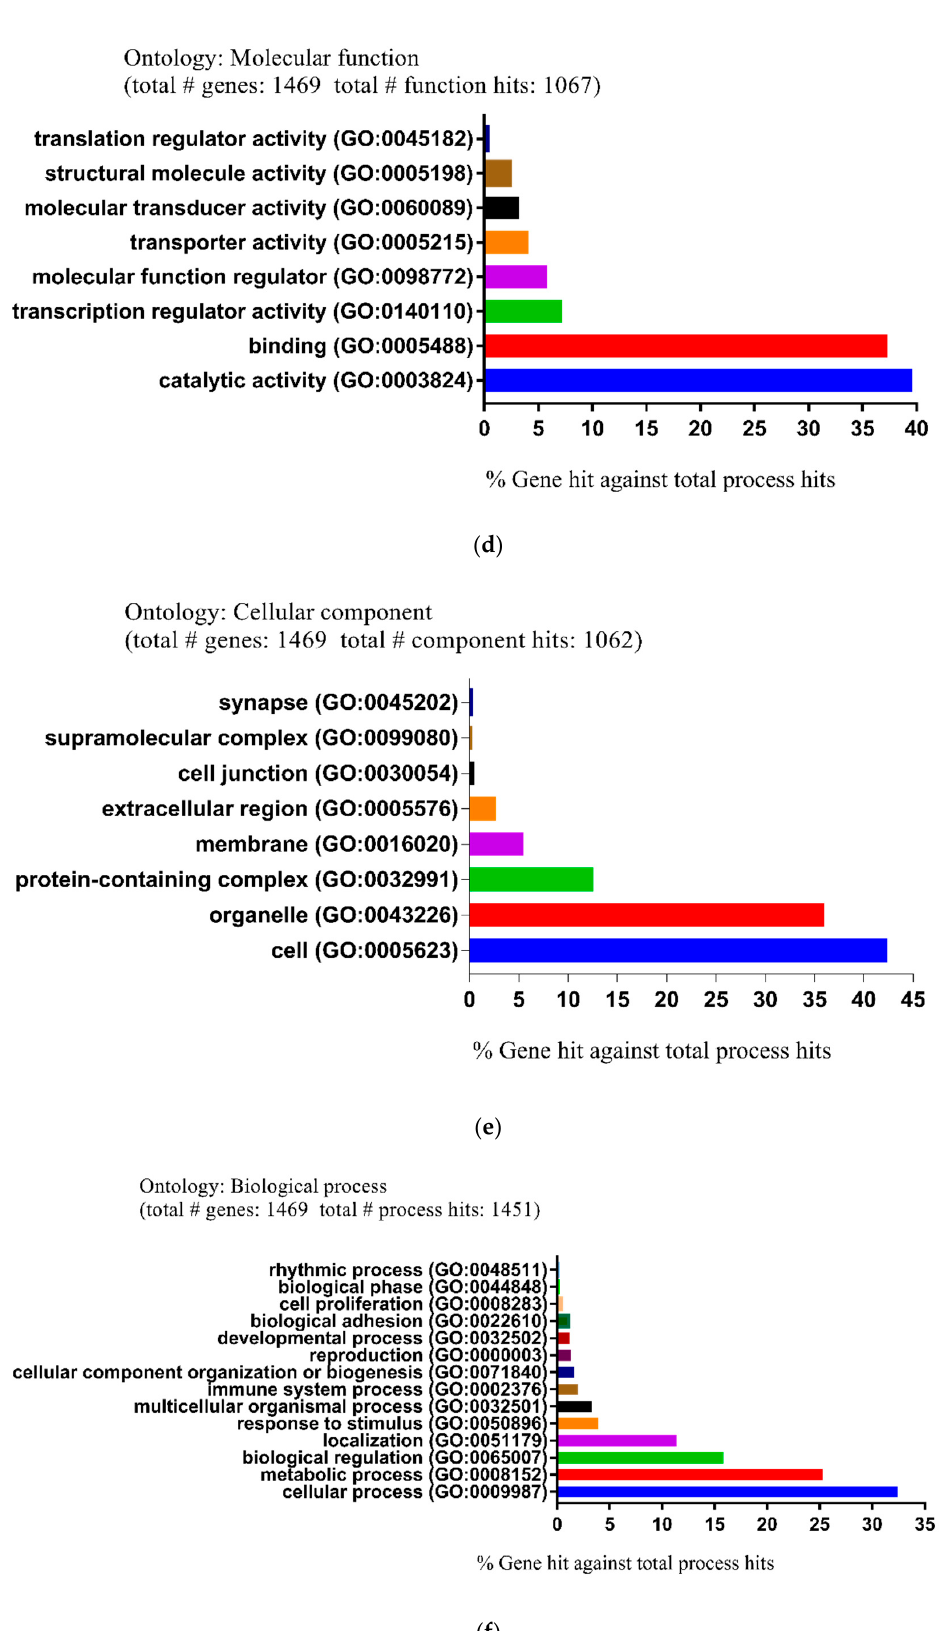
Figure 4. Functional and pathway enrichment analysis of identified modules associated with DEGs. The DEGs were subjected to gene ontology (GO) classification using the PANTHER GO classification system. Group 1: ( a ) Molecular function (MF). ( b ) Cellular component (CC). ( c ) Biological process (BP). Group 2: ( d ) Molecular function (MF). ( e ) Cellular component (CC). ( f ) Biological process